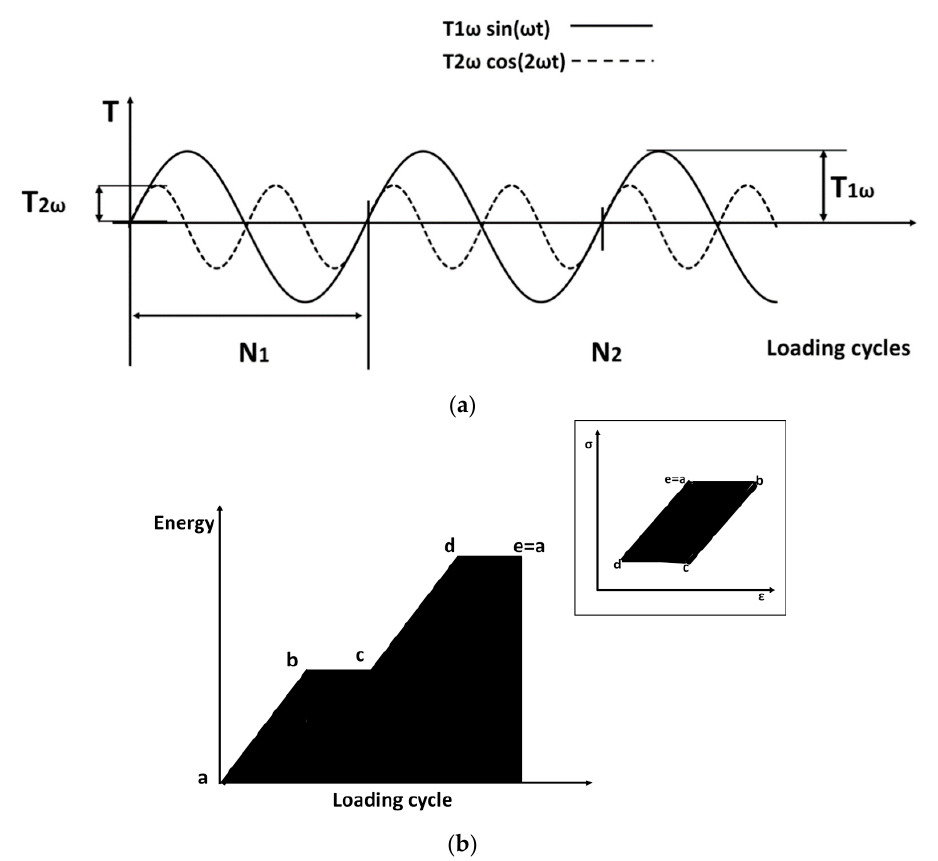
Figure 1. Thermoelastic components ( a ) energy increase from hysteresis loop ( b ).